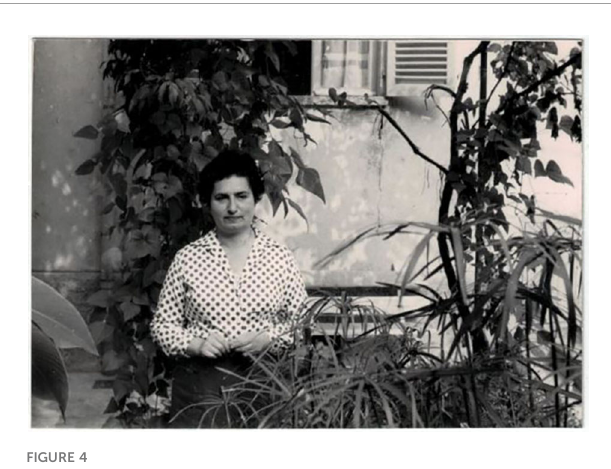
FIGURE 4 Jole Ceruti Scurti in her garden.